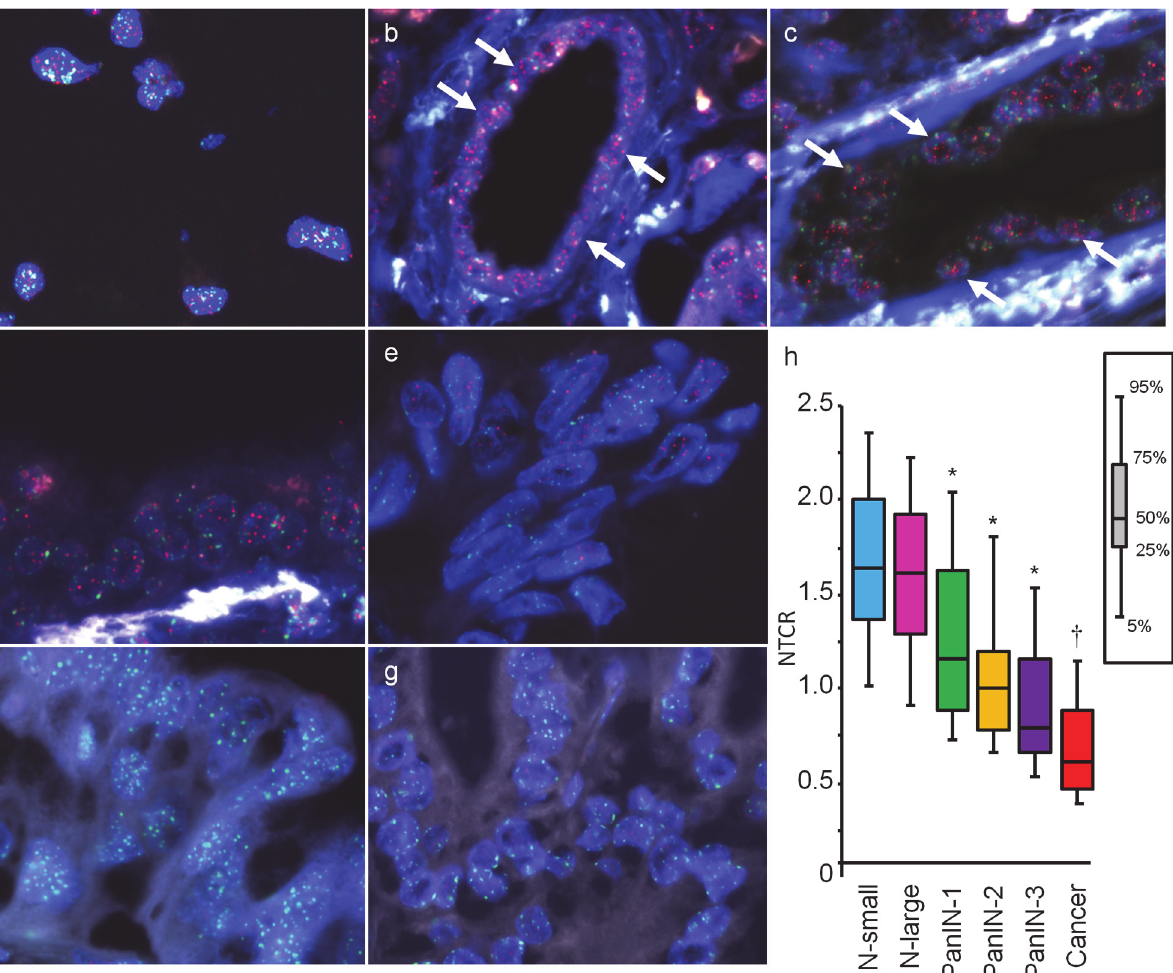
Fig 1. FISH images of the TIG-1 cell line and pancreatic ductal lesions. Original magnification, x400. Red, telomere-Cy3 signal; green, centromere-FITC signal; blue, DAPI counterstaining for DNA. (a) Q-FISH image of the control TIG-1 cell block placed on the same slide together with pancreas sections. (b-g) Q-FISH images of normal small duct (N-small) (b), normal large duct (N-large) (c), PanIN-1 (d), PanIN-2 (e), PanIN-3 (f), and pancreatic invasive ductal adenocarcinoma (g). Telomere signals were evident in normal small duct (b, arrows) and normal large duct (c, arrows), while telomere signals decreased from PanIN-1 to PanIN-3 based on visual assessment (d, e and f). Telomere signals were barely visible in cancer cells (g). (h) Box-and-whisker plot of the NTCR for each of the pancreatic ductal lesions surgically resected from patients with pancreatic cancer (n = 36) and without pancreatic cancer (n = 33). * P < 0 . 05 vs N-small and N-large. † P < 0 . 05 vs N-small, N-large, PanIN-1 and − 2.